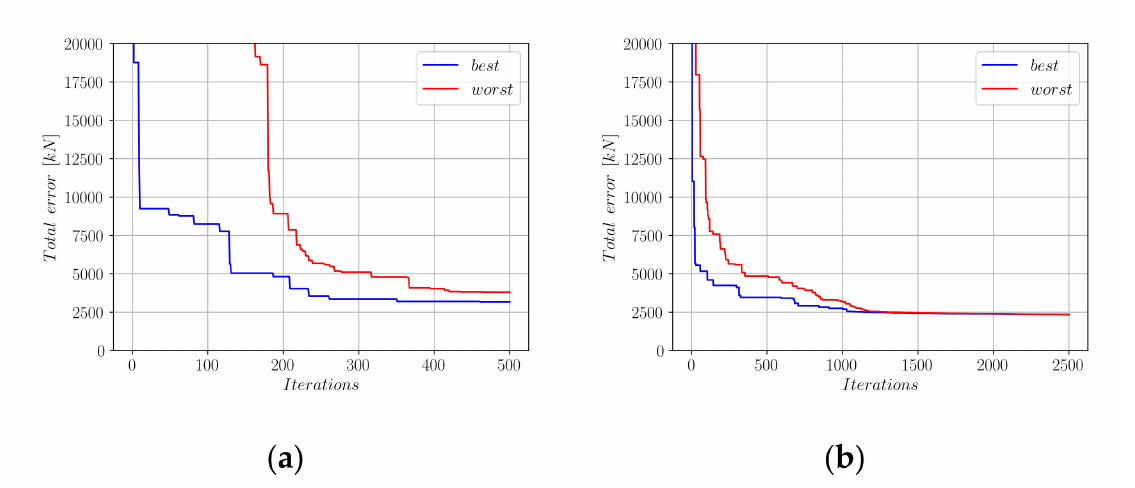
Figure 6. Decrease in the total error throughout the harmony search iterations (Equation (18)). ( a ) First 500 HS iterations; ( b ) First 2500 HS